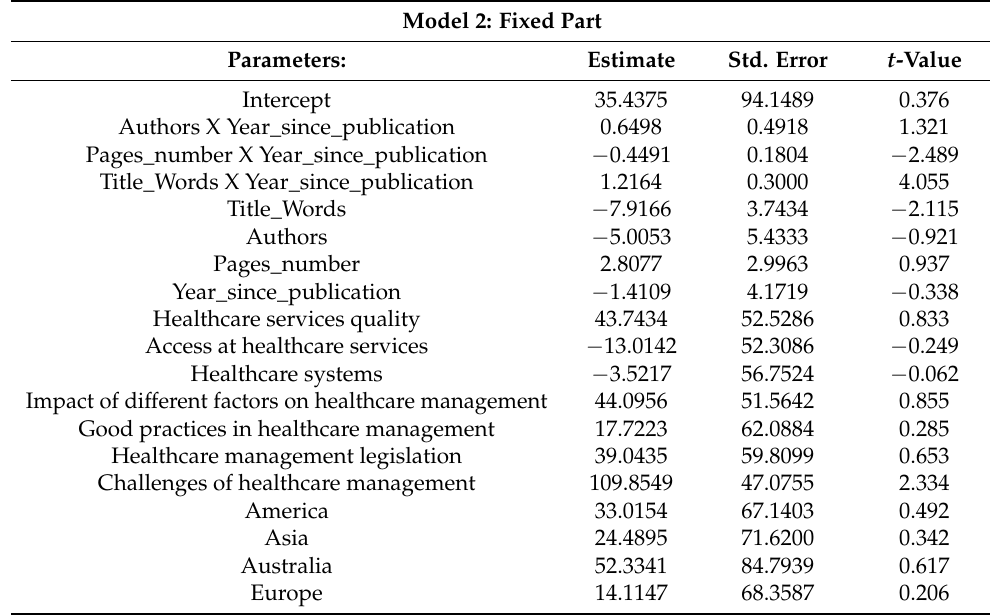
Table 6. The effect of different factors on article citations with the interaction effect of explanatory variables and a coefficient for random effects according to